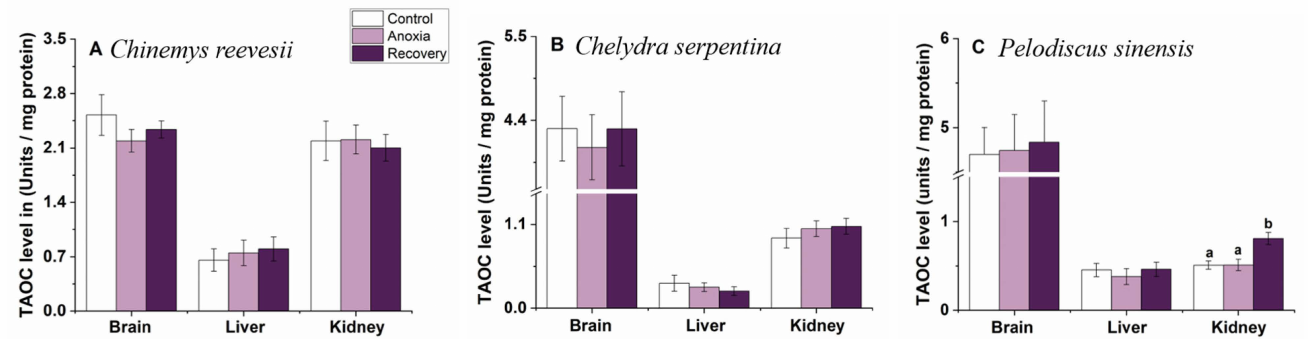
Figure 2. Effect of anoxia stress on TAOC level in tissues of C. reevesii ( A ), C. serpentina ( B ) and P. sinensis ( C ). Data are presented as mean ± SE. N = 10. Data with no common lowercase letters on the bar indicate significant differences between different groups ( p < 0.05).